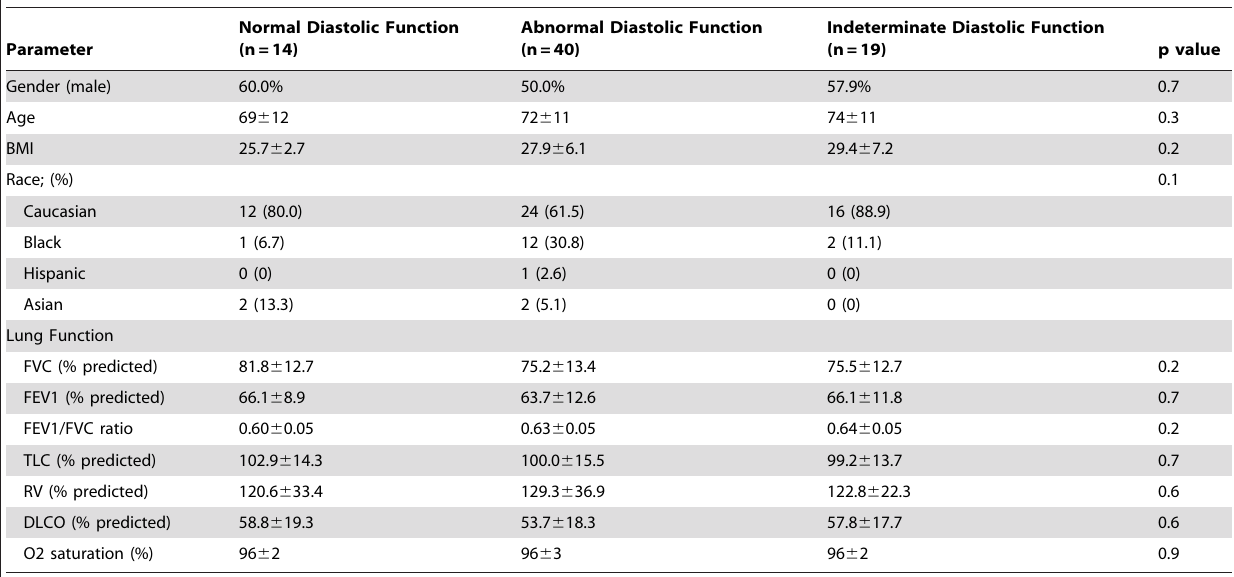
Table 4. Comparison of Diastolic Function.